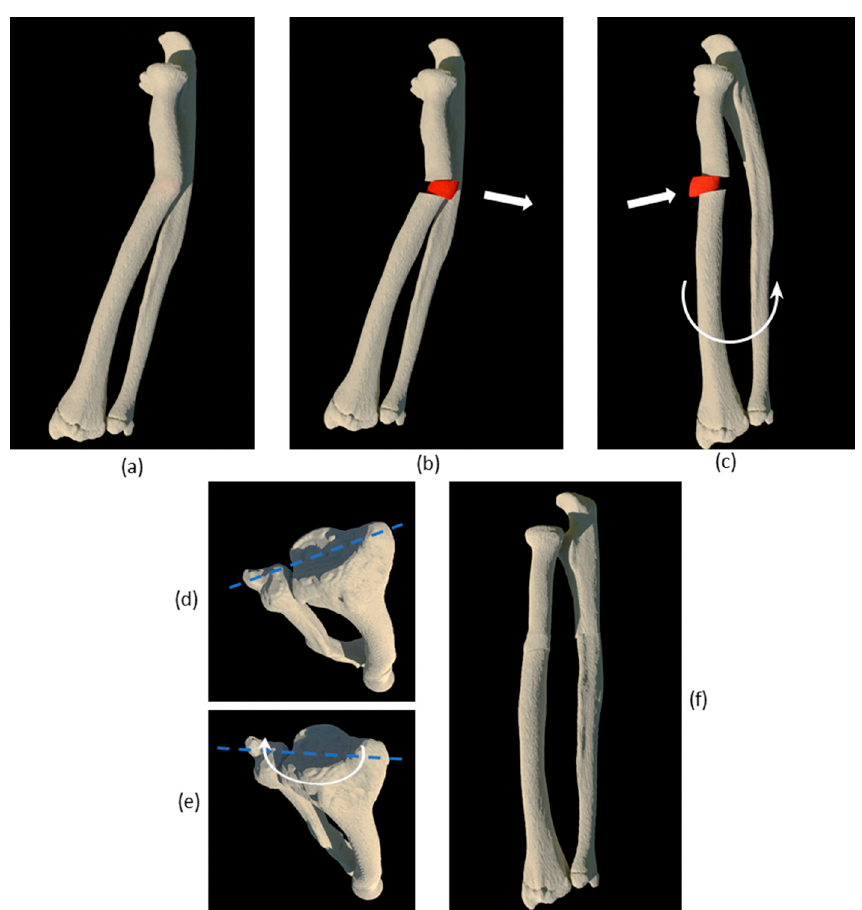
Figure 2. Video animation of the first case study: ( a ) initial configuration; ( b ) cut and rotation; ( c ) insertion of bone wedge; ( d ) final result.